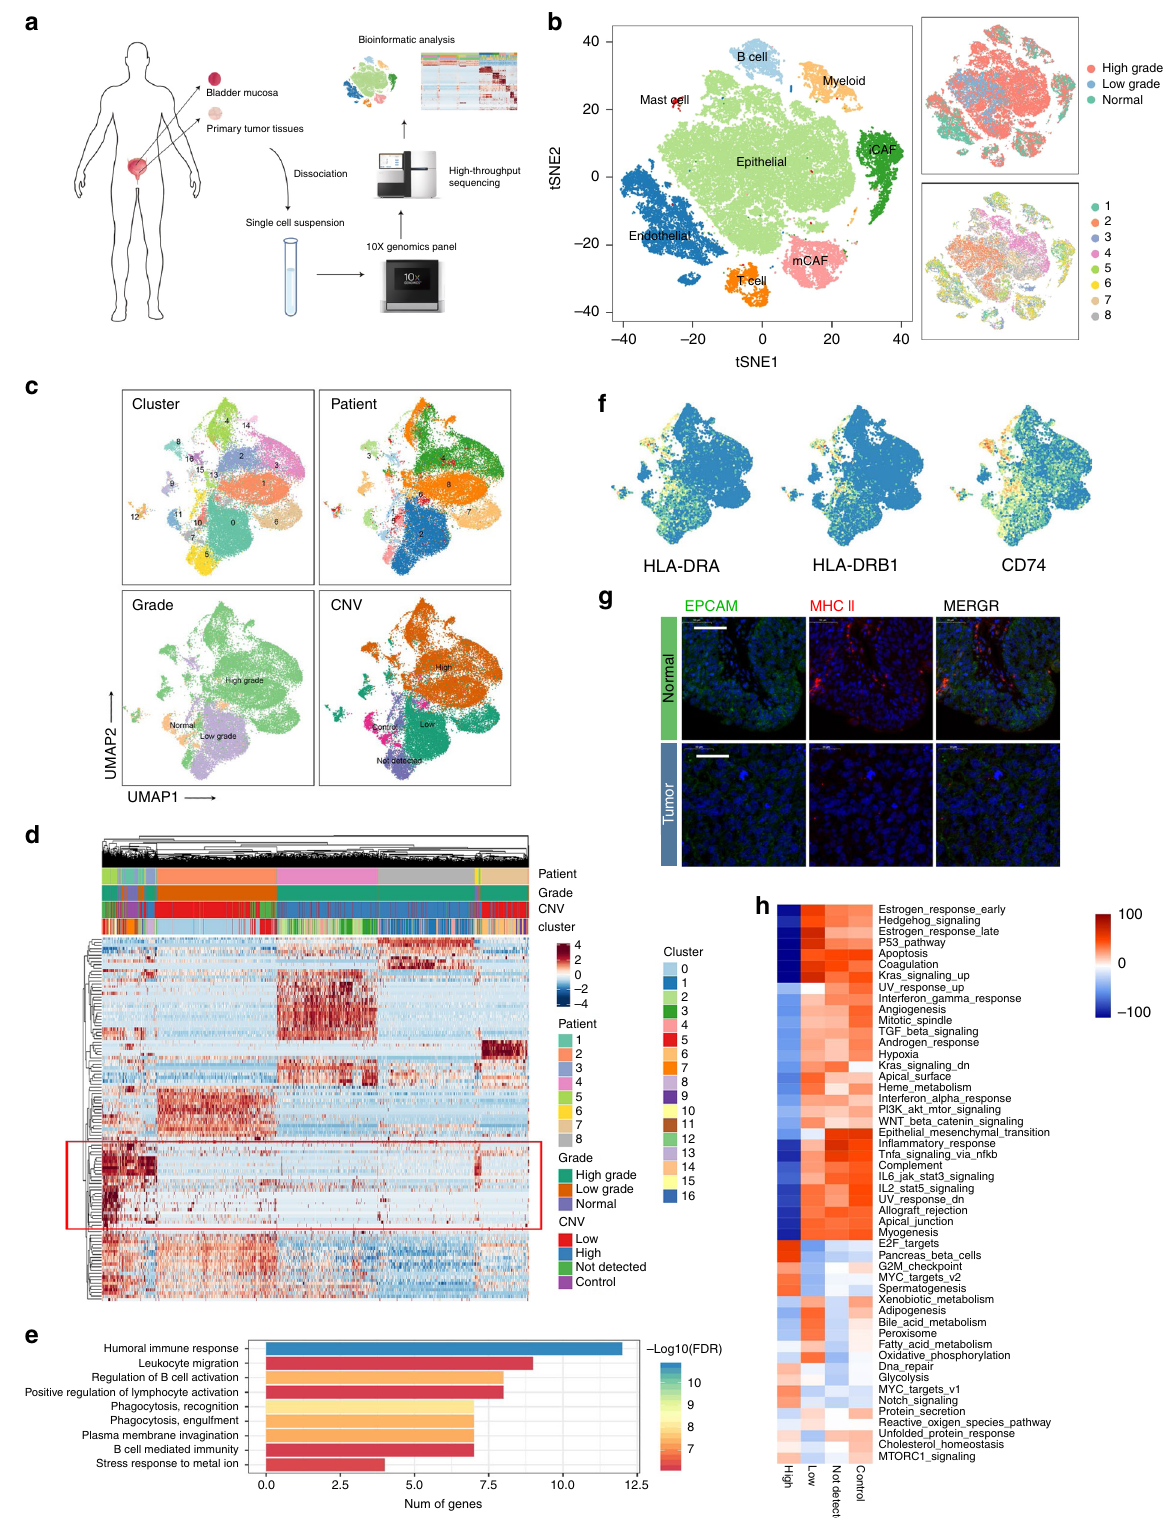
Fig. 1 Identifying in fi ltrated cell types in BC and non-malignant tissues. a , b Identifying in fi ltrated cell types in BC and non-malignant tissues. a Work fl ow of the sample preparation, sequencing and bioinformatic analysis. b tSNE plot of single cells pro fi led in the presenting work colored by major cell types, tumor grade and patient. c – h Reclustering of EPCAM + cells. c UMAP plot EPCAM + cells (epithelial marker) colored by cluster, patient, grade and CNV level. d Heatmap of differentially expressed genes (DEGs) of every CNV group. e Enriched GO functions of downregulated genes in malignant cells. f Expression levels of MHC-II molecules and CD74. g Immuno fl uorescence (IF) staining of MHC-II molecules and EPCAM. Scale bar represents 50 μ m. h Heatmap shows difference in pathway activities scored by GSVA per cell between different CNV groups. Shown are t -values from a lineal